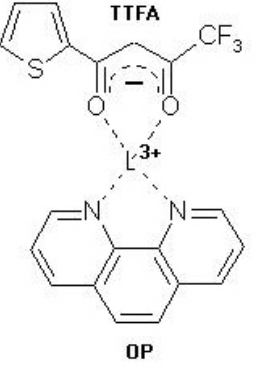
FIGURE 3. Binding of OP and TTFA to